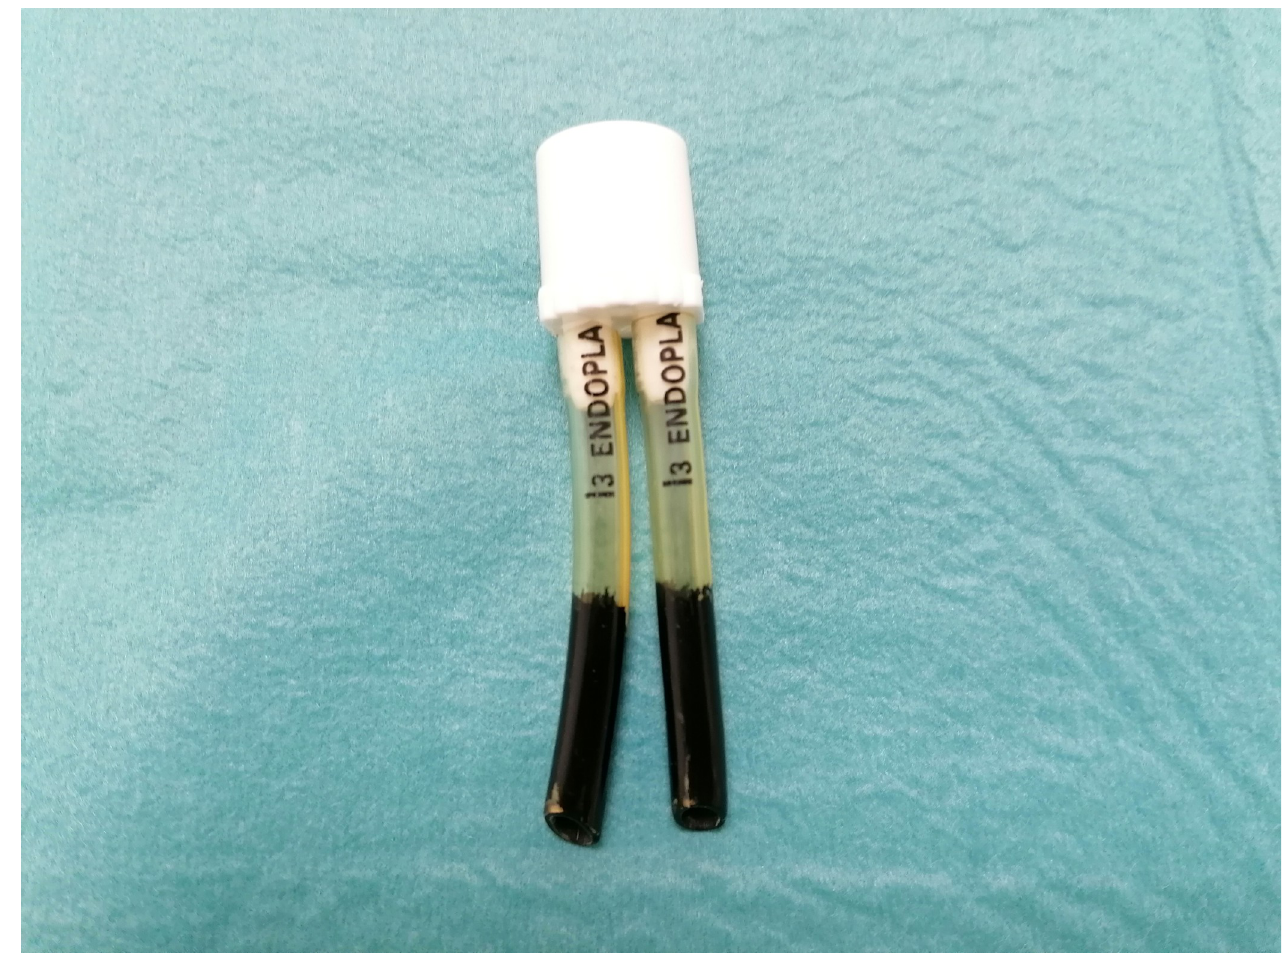
Fig 1. Short customized tightly-fitting binasal